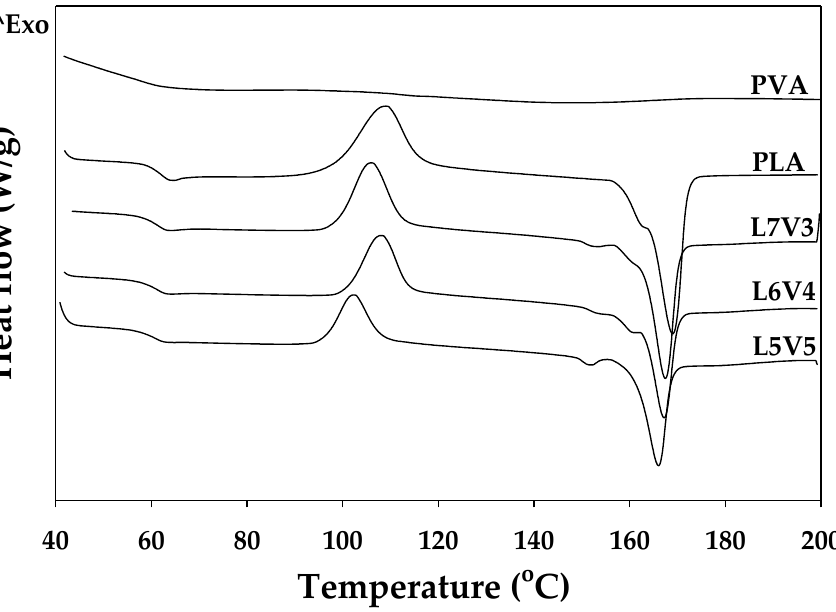
Figure 13. Second heating scan DSC thermograms of injected samples. Table 2. Thermal data obtained from the second scanning DSC thermograms.